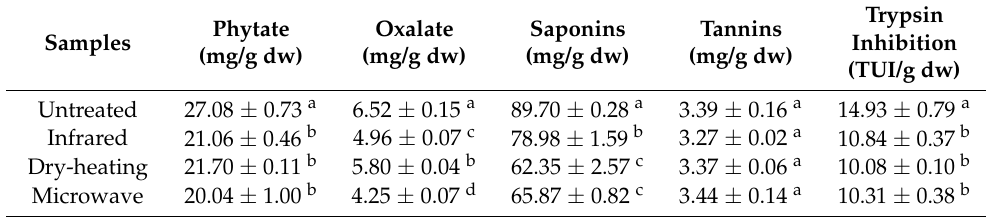
Table 3. Antinutritional composition of RB samples before and after heat